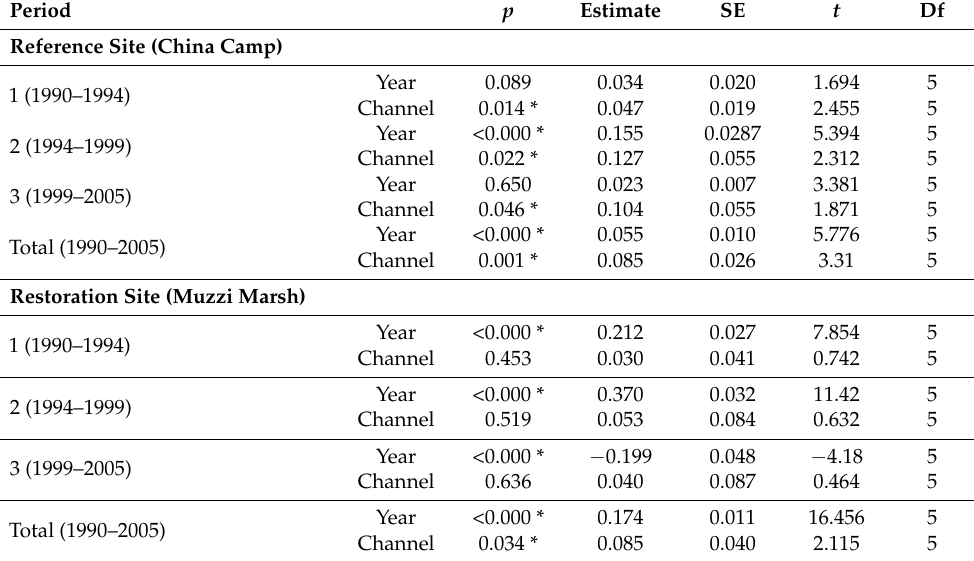
Table A3. Plant community dissimilarity from the initial year. For each period, the change is analyzed using the last year of the previous period as the starting point. Dissimilarity is calculated relative to the 1990 community to discern directional change over time. Both reference and restoration sites exhibit significant directional change over time, but the magnitude of change is higher at the restoration site. Change is only significant during period 2 (low salinity) at the reference site, but is significant over all three periods at the restoration site. Over all periods at the reference site, he change is concentrated in plots containing channels because sub-dominant diversity is driving community change, while at the restoration site, where change is driven by the interactions between three pioneer species in addition to sub-dominant species, the channel is only significant when considering the entire study